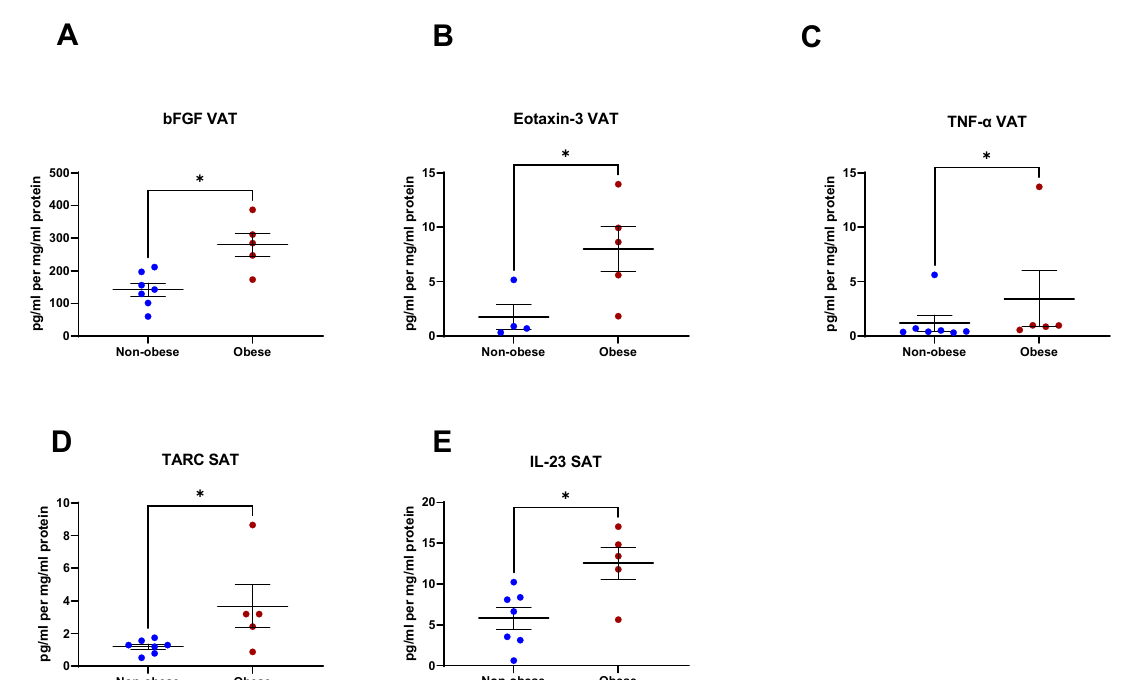
Figure 7. Secreted factors are altered in the visceral adipose tissue (VAT) and subcutaneous adipose tissue (SAT) based on the obesity status of the patient. ( A ) bFGF, ( B ) Eotaxin-3, and ( C ) TNF- α are secreted at significantly higher levels from the VAT of obese patients compared to non-obese patients. ( D ) TARC and ( E ) IL-23 are secreted at significantly higher levels from the SAT of obese patients compared to non-obese patients. Statistical analysis was performed using a Mann–Whitney U-test. All data expressed as mean ± SEM. n = 5 for obese patients, n = 7 for non-obese patients, n = 4 for non-obese patients for Eotaxin-3. * p < 0.05.